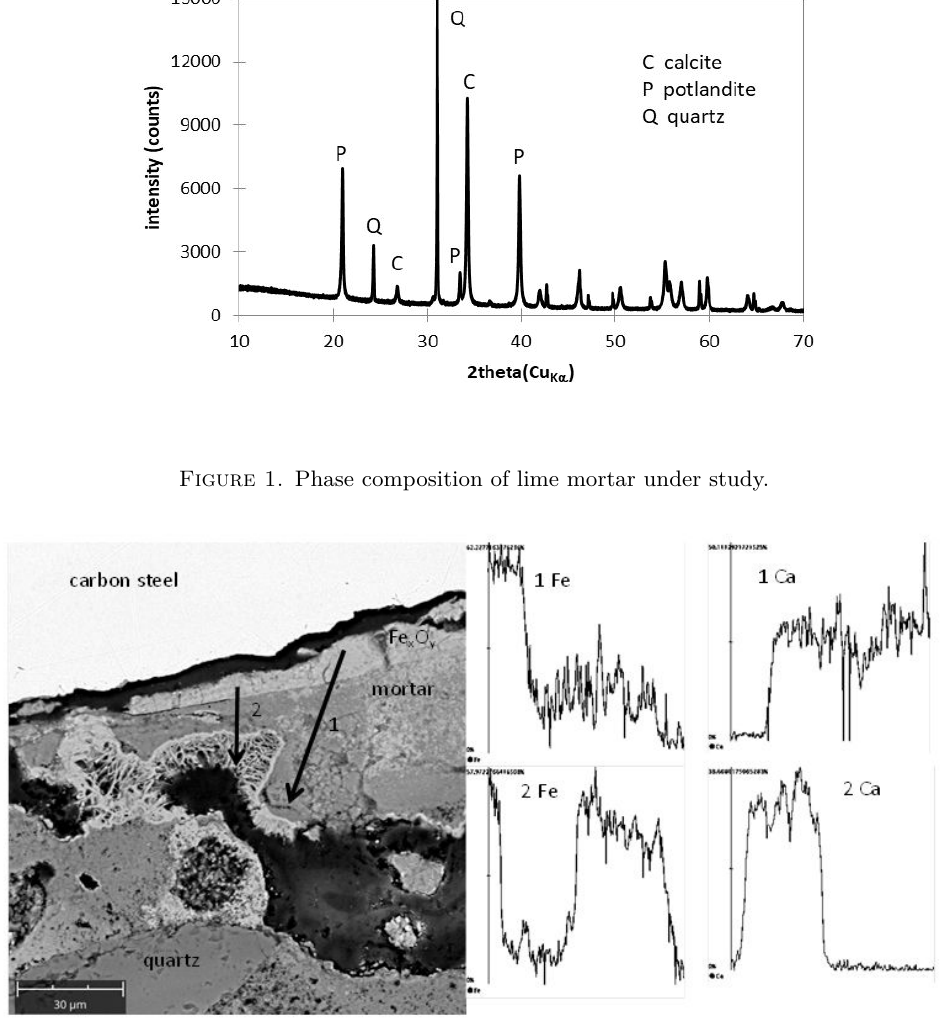
dendritic Fe x O y structure appeared. The line scan